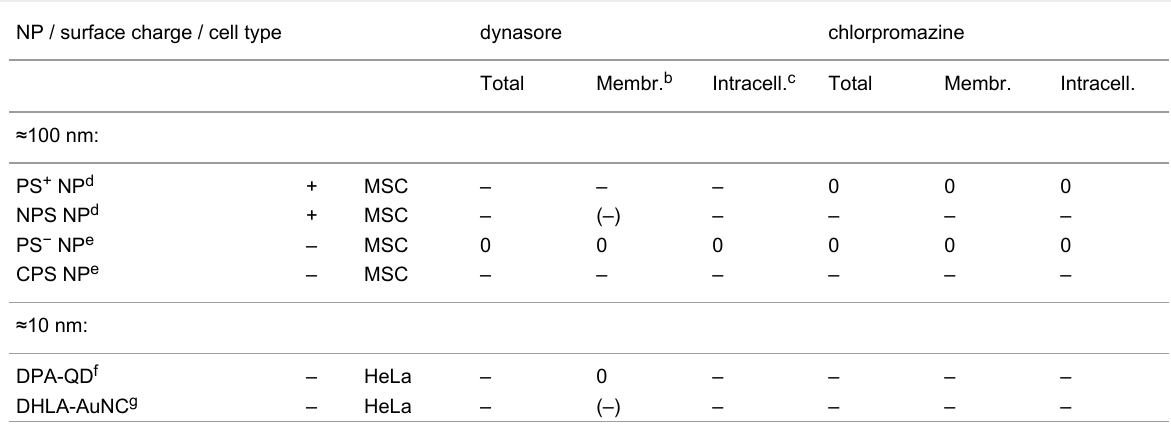
Table 2: Effects of inhibitors on NP uptake a